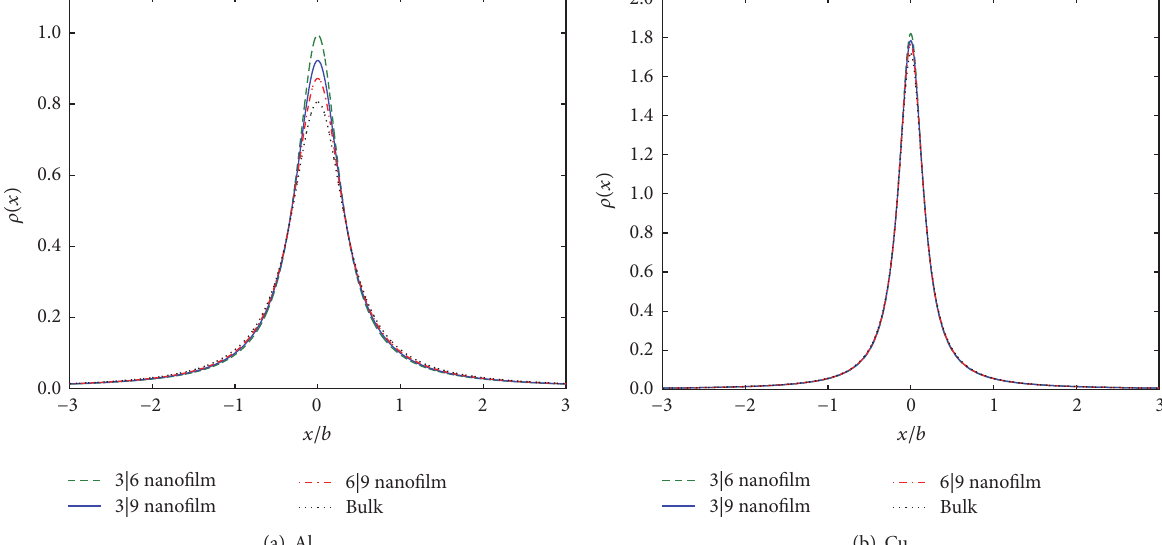
Figure 7: Dislocation densities of the (1/2)⟨110⟩{111} screw dislocations in Al and Cu nanofilms for different ℎ | (𝐻 − ℎ)